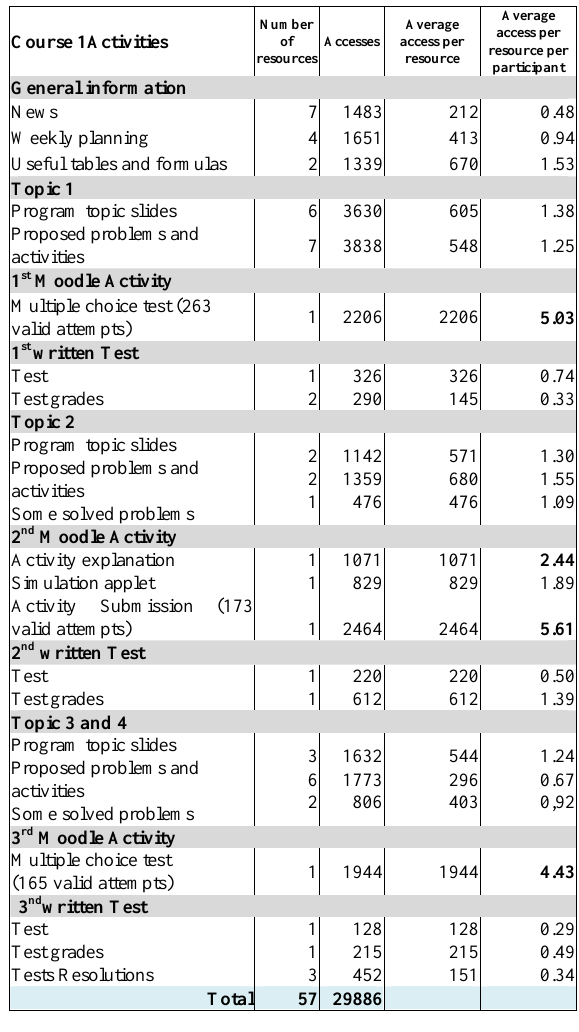
TABLE III. M OODLE C OURSE 1 ACESSES PER RESOURCE AND PARTICIPANT